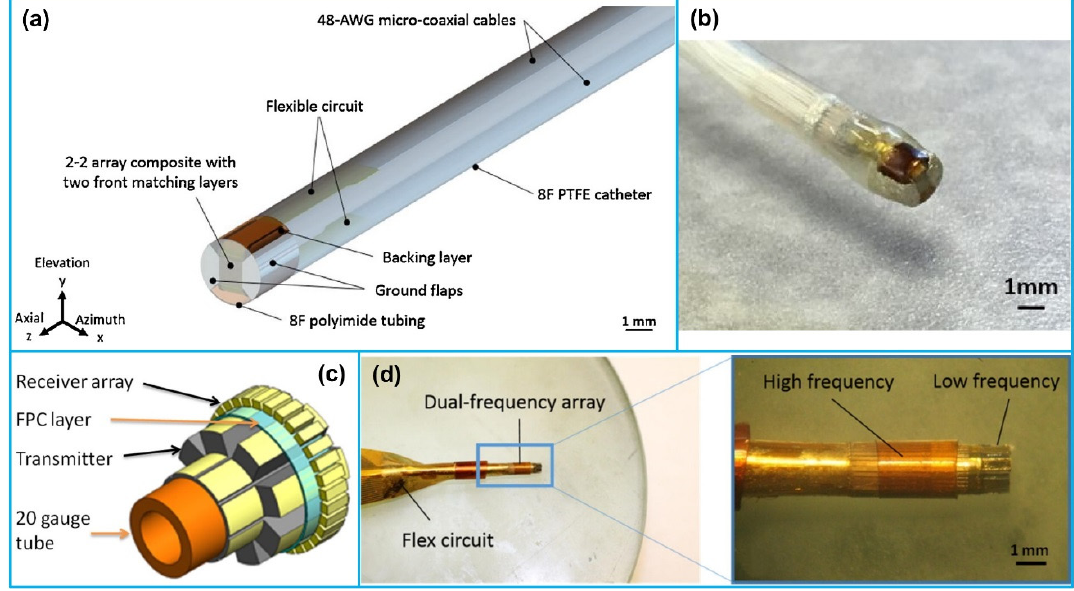
Figure 9. A 30 MHz forward-looking phased array transducer for IVUS imaging: ( a ) schematic of the array structure enclosed in an 8 Fr catheter; ( b ) photograph image of the packaged phased array transducer. Reprinted from [140] with permission. A dual frequency cylindrical array for contrast enhanced IVUS imaging: ( c ) illustration of the dual frequency cylindrical array structure; ( d ) photograph images of the fabricated dual frequency cylindrical array. Reprinted from [143] with permission.